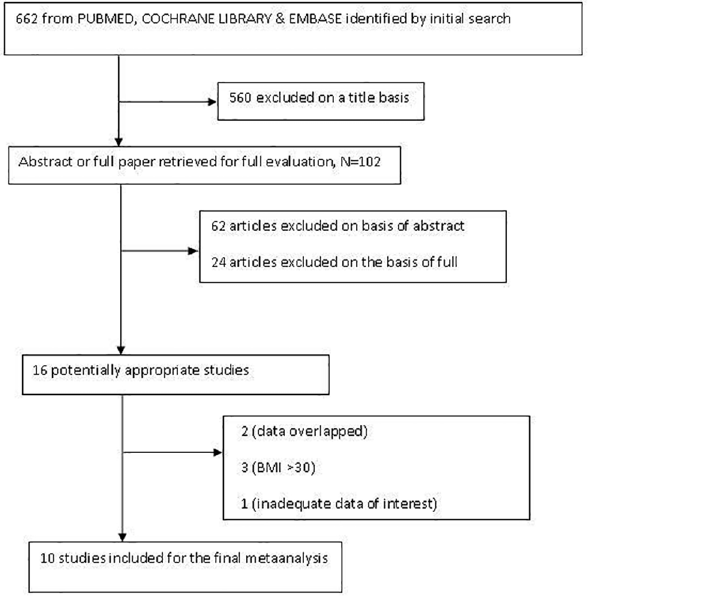
Fig 1. Flow chart of article selection.